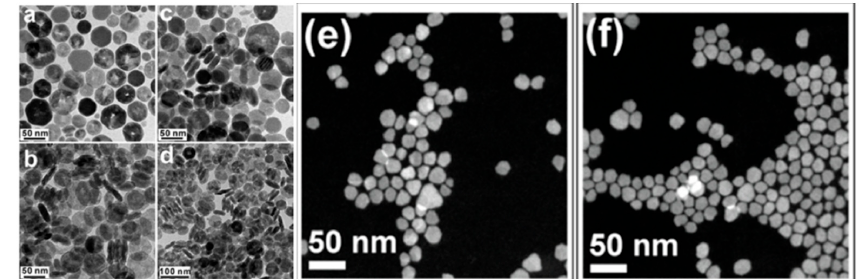
Figure 6. Top: Scheme of the synthesis of copper indium sulphide (CIS) [129] and copper zinc tin selenide–sulfide (CZTSeS) [130] nanoplatelets (NPLs) via cation exchange technique. Bottom: ( a – d ) TEM images of CIS nanocrystals. and ( e – f ) scanning TEM images of CZTSeS NPLs via cation exchange technique. Reproduced with permission from [129]. Copyright American Chemical Society, 2015. Reproduced with permission from [130]. Copyright American Chemical Society, 2014.